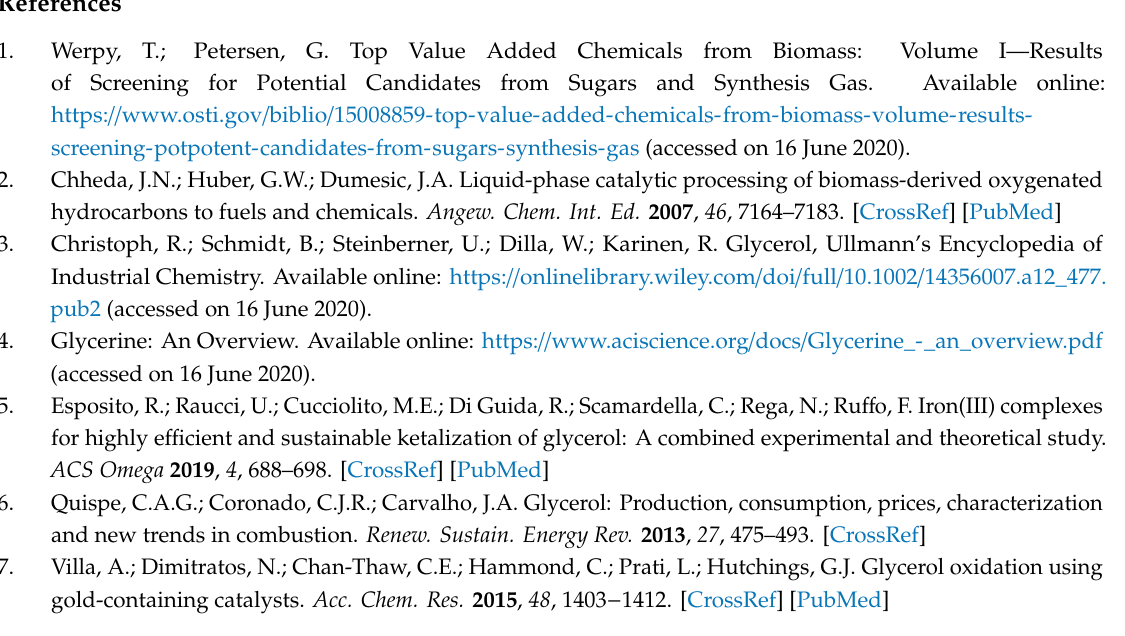
Figure S1: XRD patterns for di ff erent catalysts and their corresponding supports: (a-e) from [38], (f) from [37], g from [42]; Figure S2: TEM images and particle size distributions of gold supported catalysts: (a-e) from [38], (f) from [37], g from [42]; XPS results from di ff erent catalysts: (a–e) from [40], (f) from [37], g from